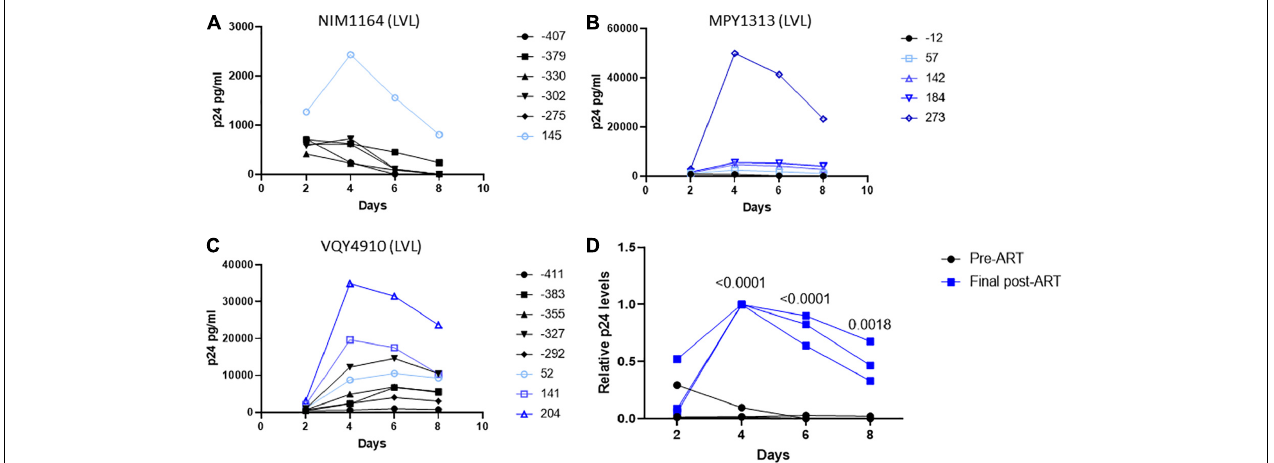
FIGURE 5 | Suppression of viral load in LVLs by ART results in loss of in vitro control of viral replication. Longitudinal PBMC samples from LVLs (A–C) placed on ART. PBMCs were induced with PHA and IL-2 then infected with NL4-3 48 h later. Supernatant was collected every 48 h post infection and virus levels were determined by p24 ELISA. (D) Comparison of relative p24 levels pre- vs final post-ART for LVL donors. One-way ANOVA was performed. (A–D) Numbers indicate days post-ART. Black lines are pre-ART PBMC cultures and blue lines are post-ART.